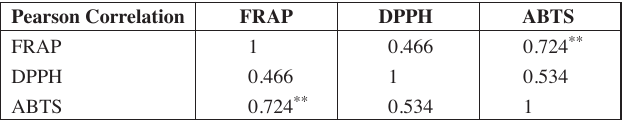
Tab. 3: Pearson correlation between three methods of determining anti- oxidant activity Pearson Correlation